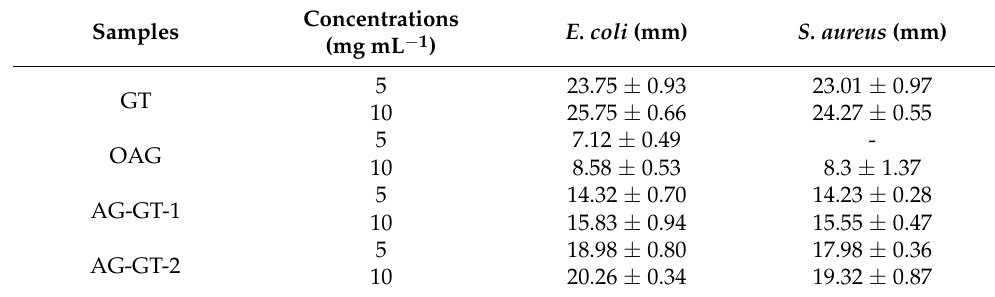
Table 2. Diameter of inhibition zone for GT, OAG, AG-GT-1 and AG-GT-2.